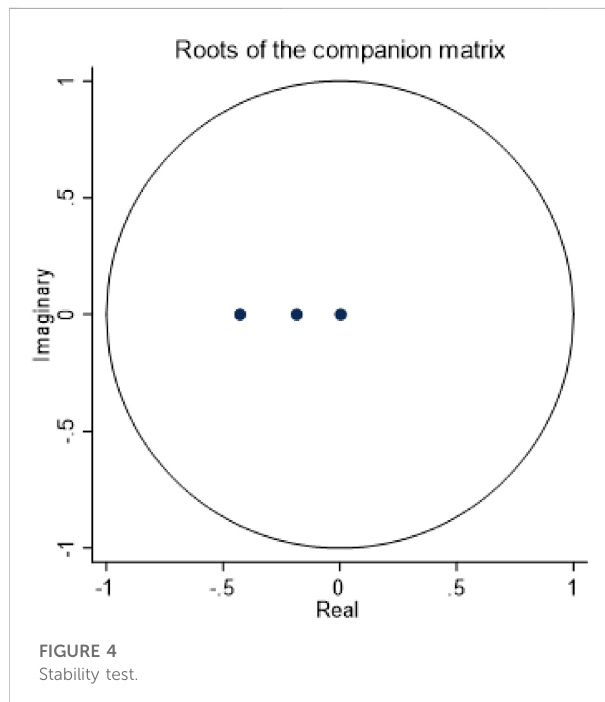
FIGURE 4 Stability